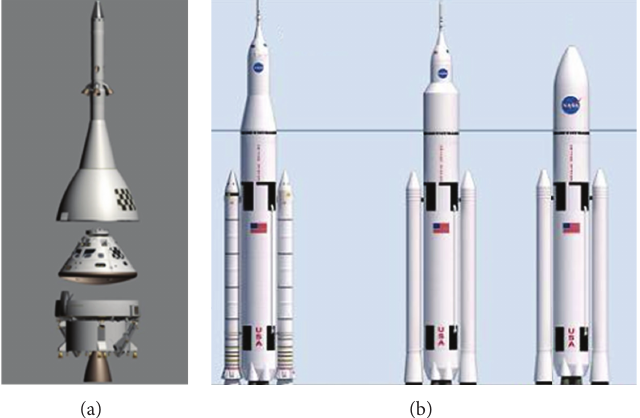
Figure 4: The MPCV and SLS [32, 33]. (a) Multipurpose Crew Vehicle (MPCV) [21]. (b) Evolution of the Space Launch System (SLS) [15].